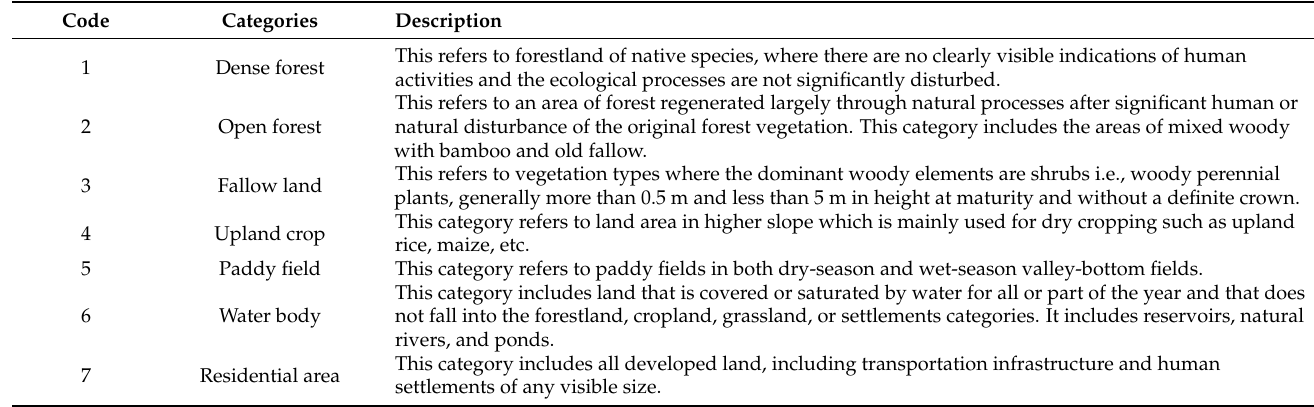
Table A2. Land-use and land cover